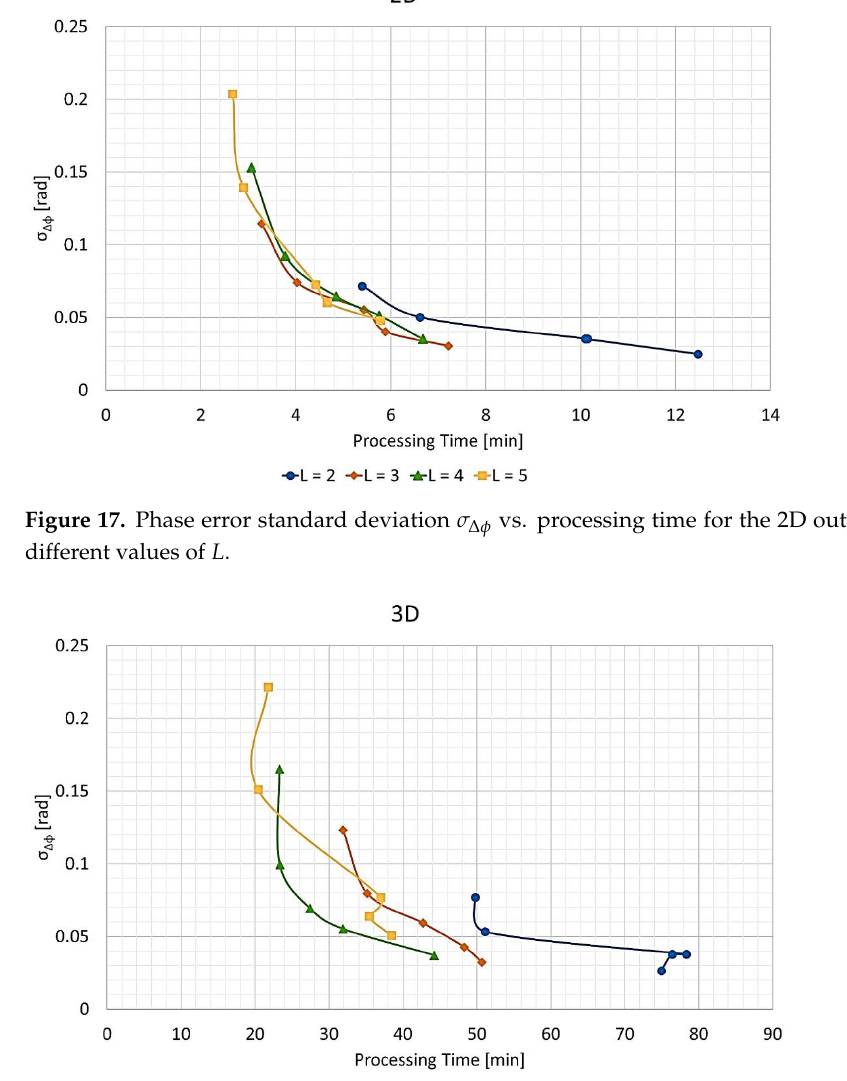
Table 5. Processing time of the slowest, fastest, and average FFBP configurations compared to the BP algorithm. Image Type